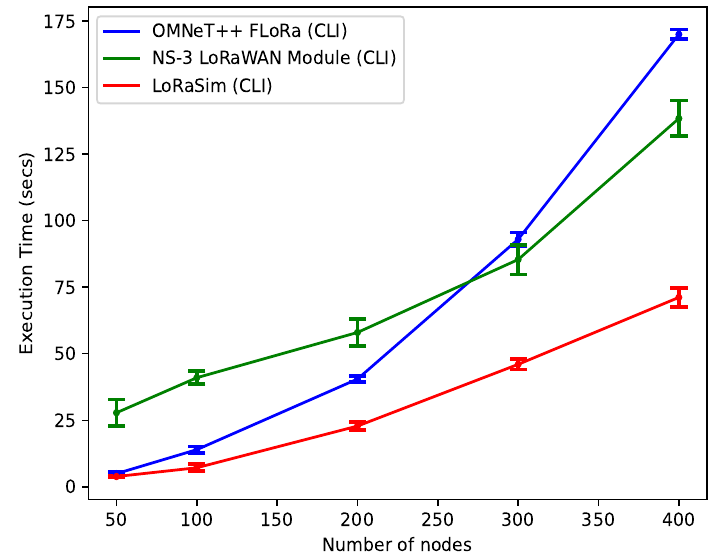
Figure 10. Execution time vs. number of